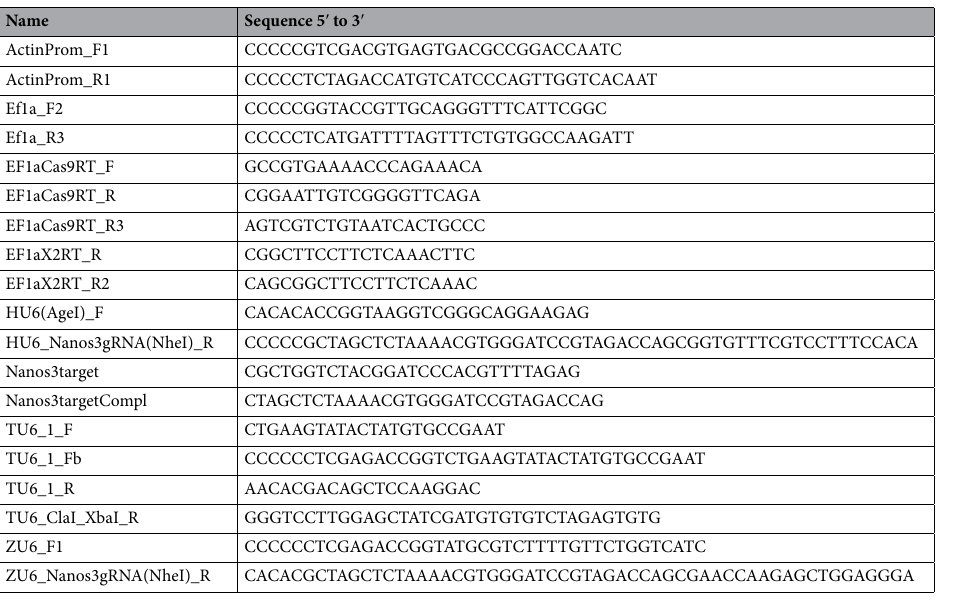
Table 2. Sequences of all primers and oligos mentioned in the materials and